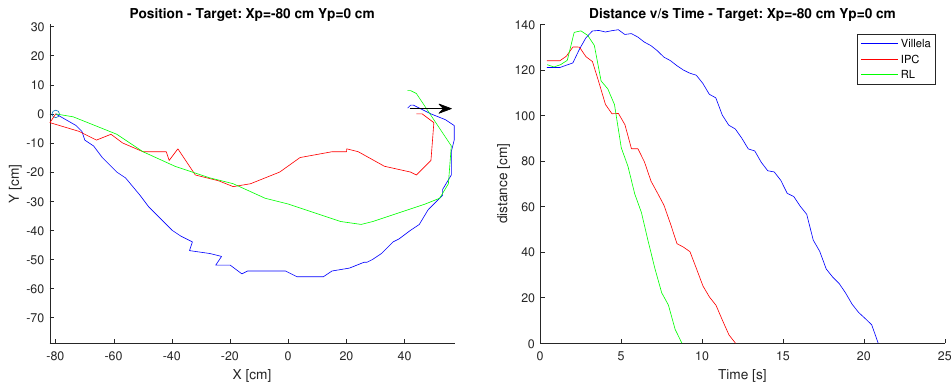
Figure 13. Position and distance to target X p = − 80 cm, Y p = 0